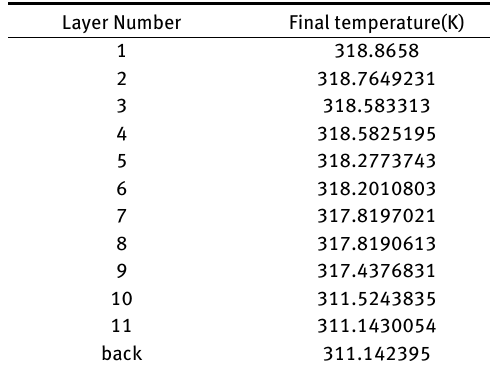
Table 4. Final temperature of each layer of solar panel